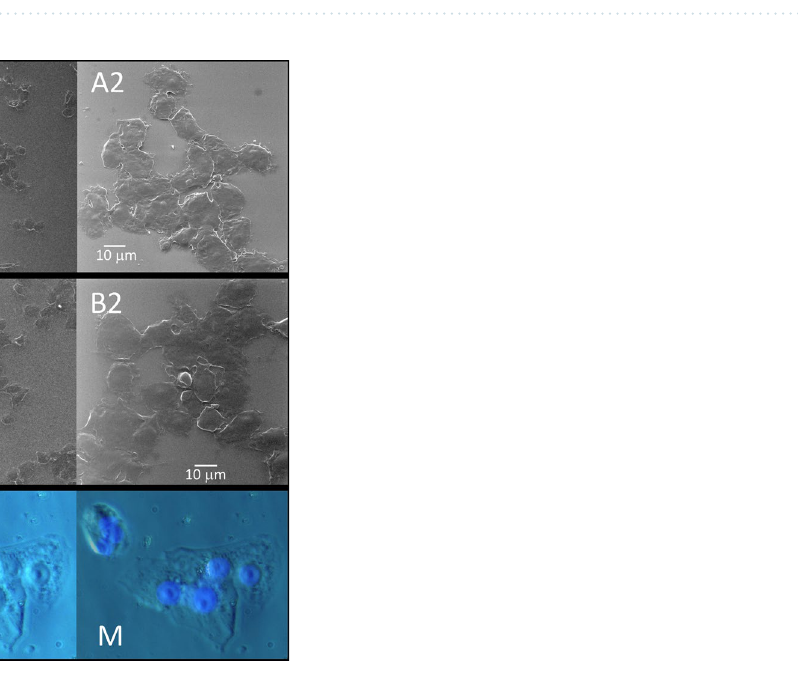
Figure 6. TNT stretched between two host cells. A TNT under mechanical tension between two cells (C1 and C2) lies on the well floor. Fully flat healthy cells and a trio of bulging and detaching infected cells (asterisk in A1) can be seen nearby. This stretched TNT pulls on both cells, shaping them with a stretched morphology (A2). We ruled out the possibility that this tension could be caused by the dehydration process because correlative microscopy showed the same stretched morphology in the hydration state in Phase Contrast prior to HeIM (blue inset). Stretched TNT between two cells often present a bulging mid-way (dotted arrow; magnified in A3) (magnification in A1 × 2700; in A2 × 10,800; in A3 × 77,000).